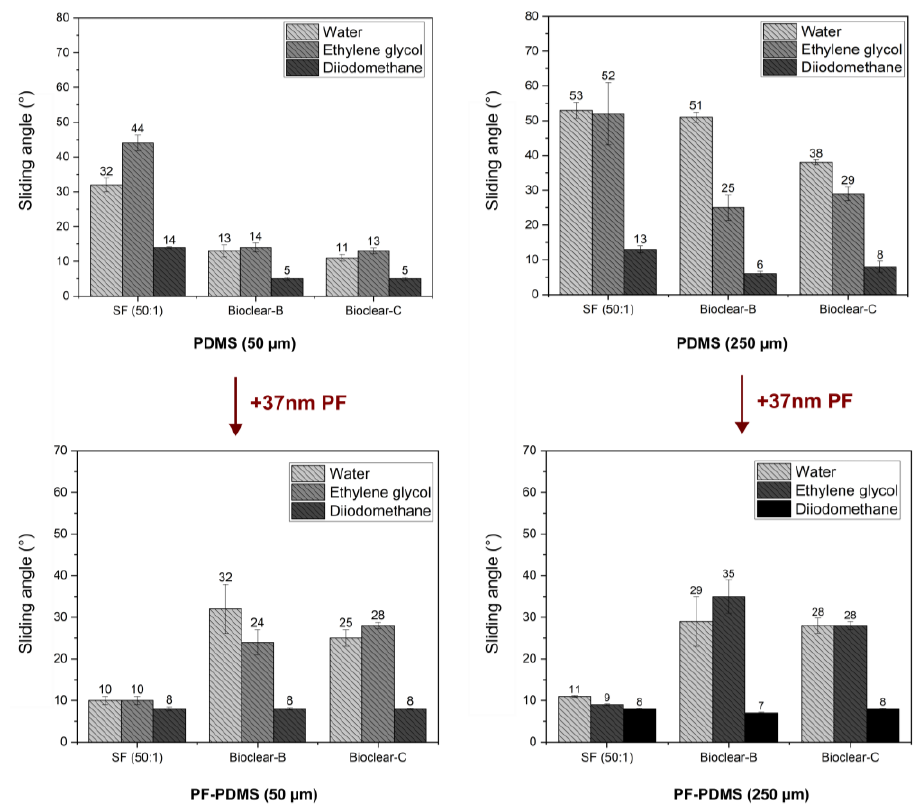
Figure 6. Dewetting behavior of water, ethylene glycol and diiodomethane on soft and PF-coated PDMS with a thickness of 50 µ m and 250 µ m. The wetting behavior is independent of the PDMS layer thickness, indicating that the PF-coating eliminates the effect of soft wetting. The SA values of PF-Bioclear correspond well with the SA values of pristine parylene F on a smooth surface, indicating that surface chemistry is the main influence on the wetting behavior. For SF, SA values are significantly decreased on PF-coated PDMS, indicating that the wrinkled surface structure is the main influence on the wetting behavior of